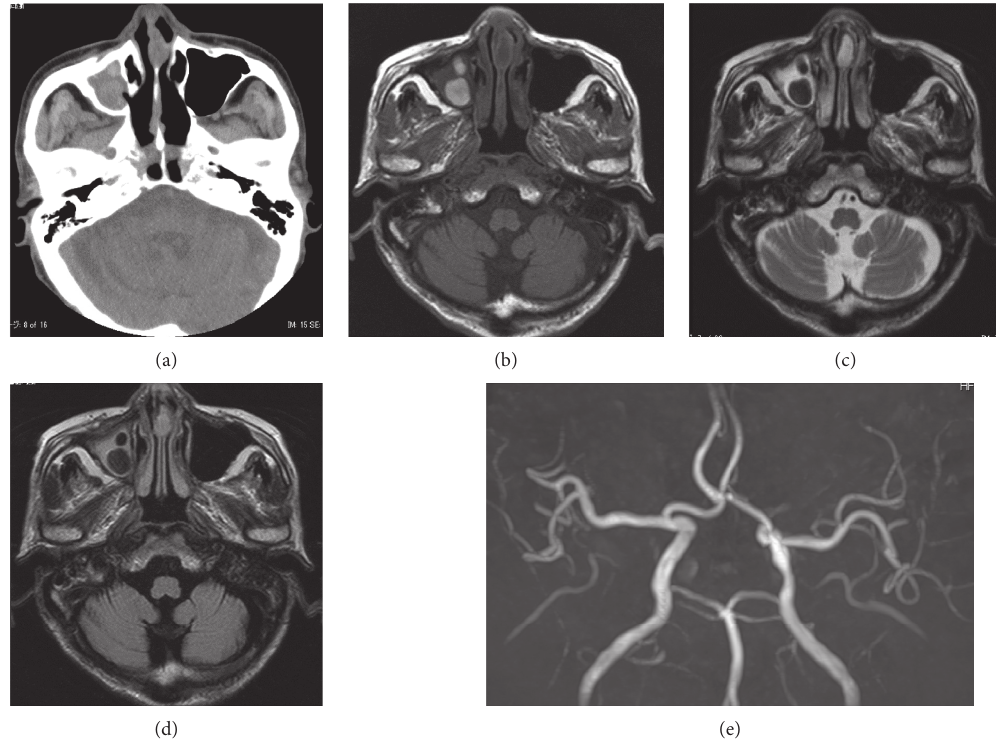
Figure 1: One month before admission: imaging included CT (a), T1-(b), and T2-weighted (c) images, fluid attenuated inversion recovery images (d), and MRA